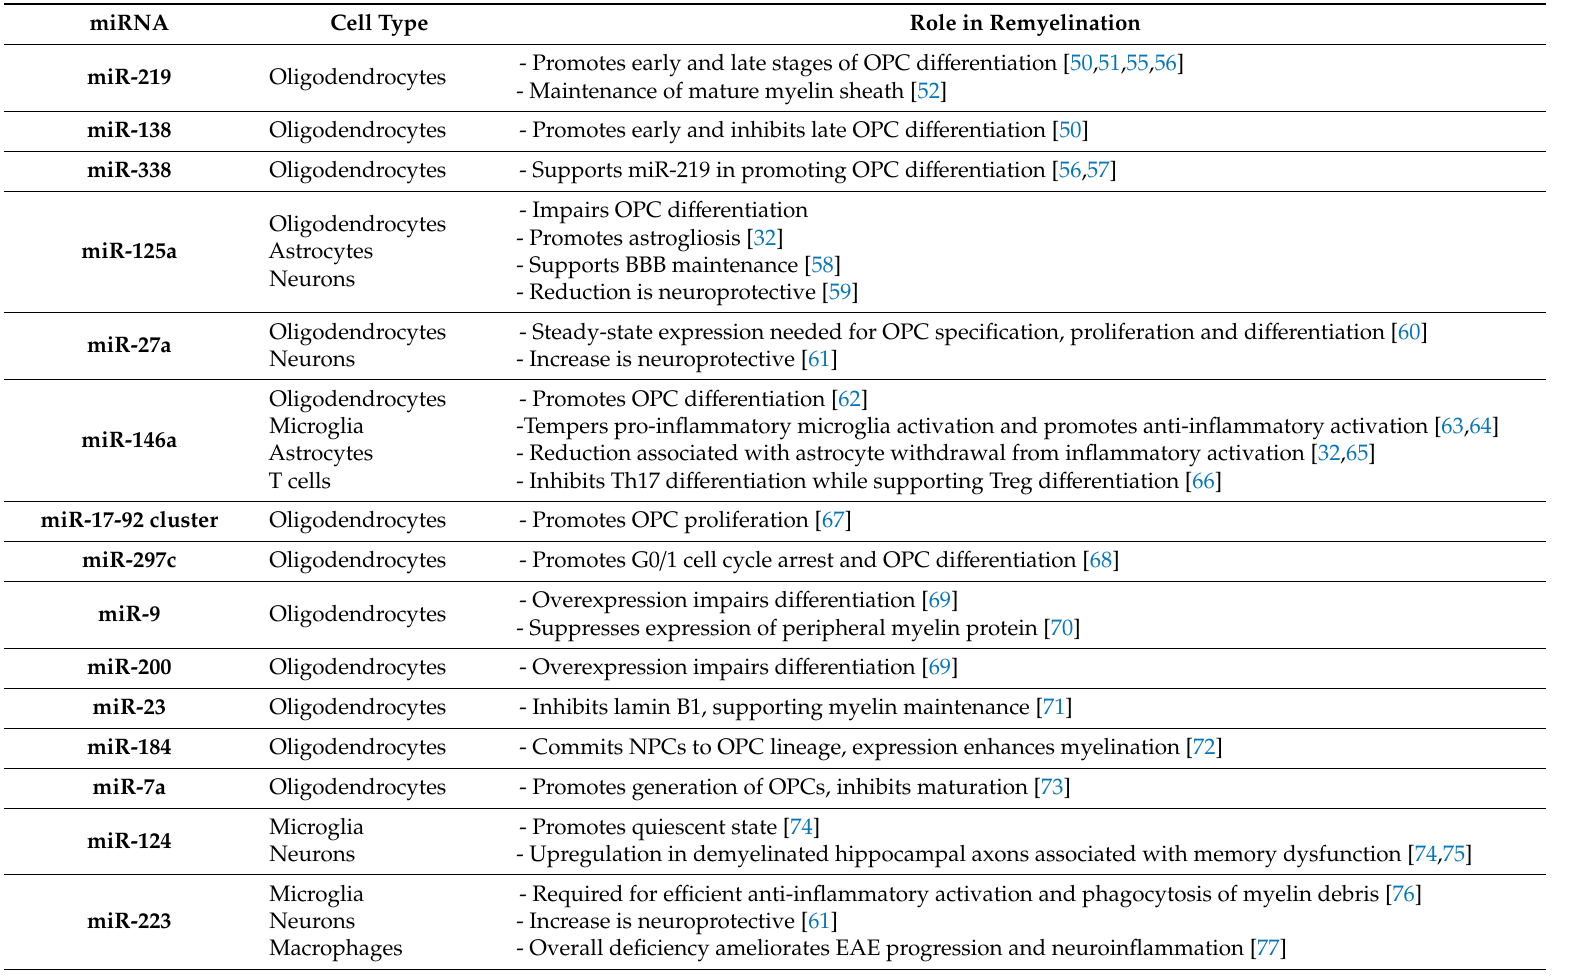
Table 1. Summary of miRNAs involved in